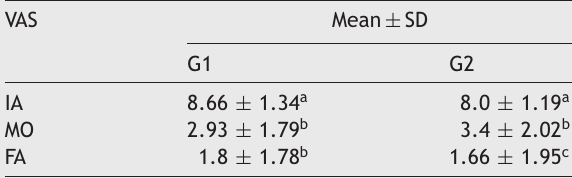
Values of mean and SD of the answers obtained for the VAS in the three stages of assessment.